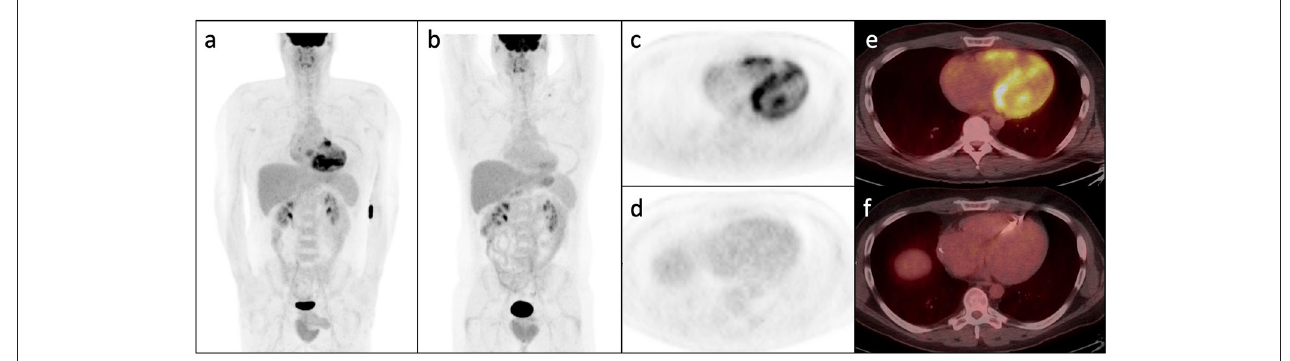
FIGURE 4 | Whole-body FDG PET (a) and axial PET and PET/CT images (c,e) following appropriate pre-test preparation demonstrating abnormal patchy increase in FDG avidity within the right and left ventricular myocardium with subtle increase in right atrial FDG uptake. (b,d,f) Show post-treatment FDG PET/CT images in the